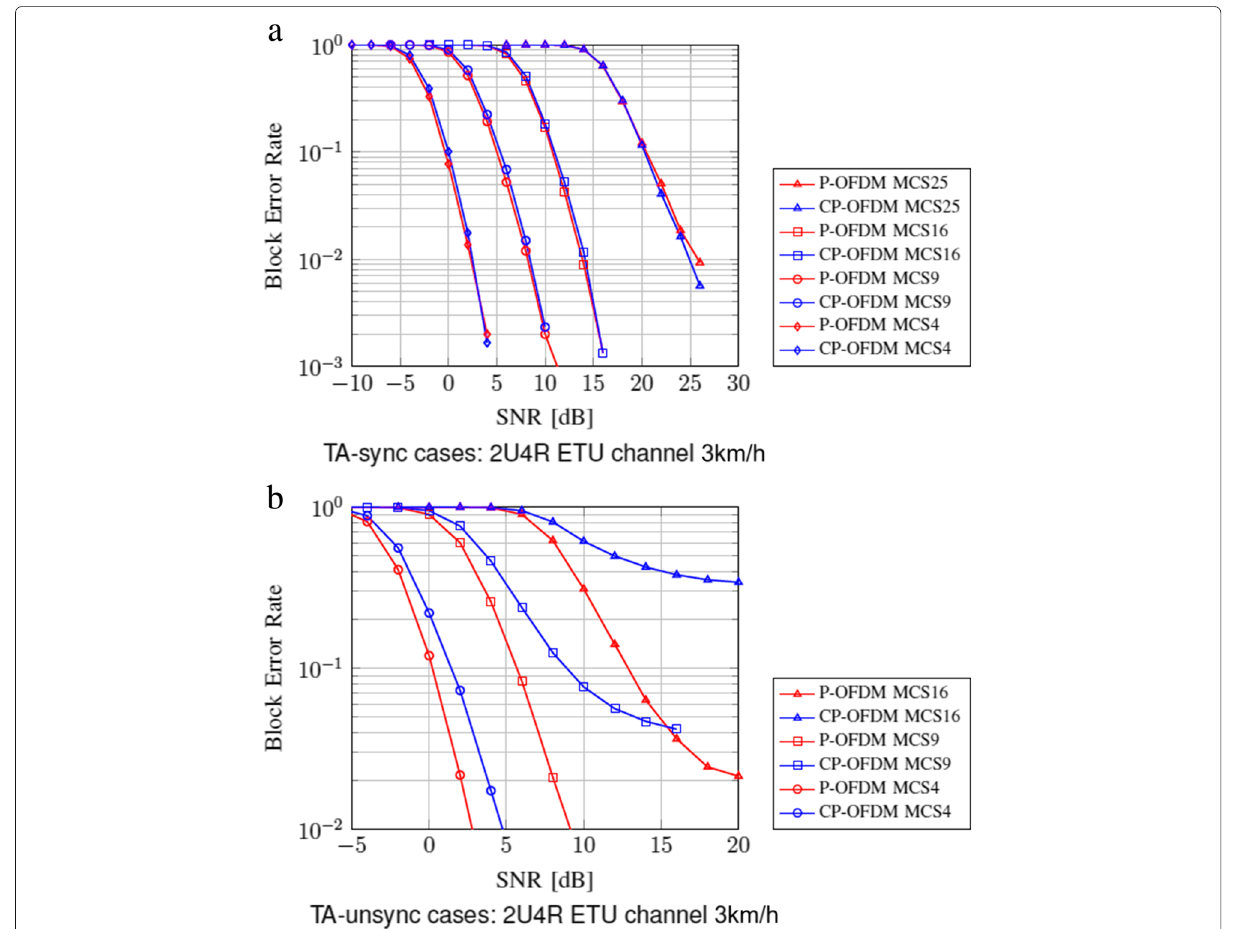
Fig. 19 a , b TA sync/unsync cases: 2U4R ETU channel 3 km/h: comparison vs. CP-OFDM